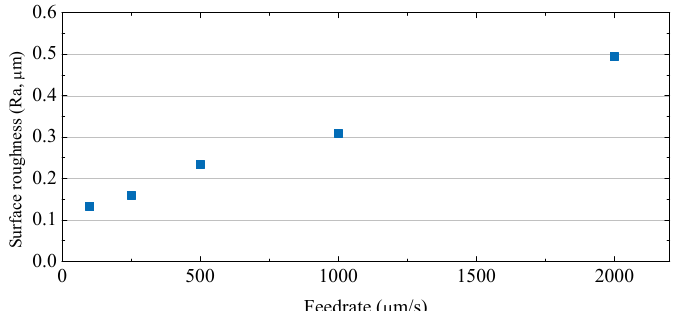
Figure 5. The surface roughness values of the channel bottoms according to the different feed rates (feed rates: 10–2000 µm/s; depth of cut: 5 µm; 50,000 rpm).